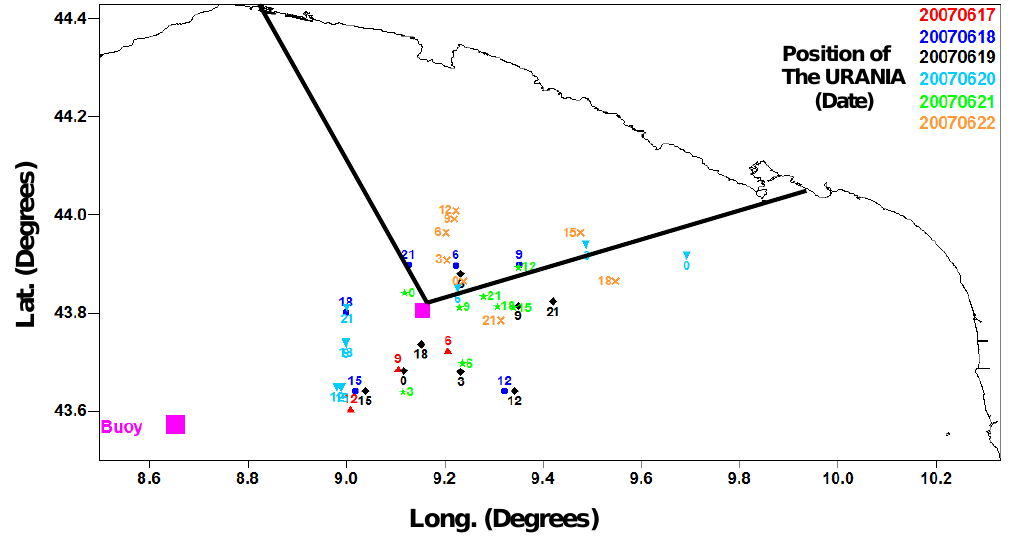
Fig. 1. Urania operational areas during LASIE. Day 21 and 22 the ship was sailing within large areas back and forth from and to the cost. The black lines delimit the “land” sector with outflow from the